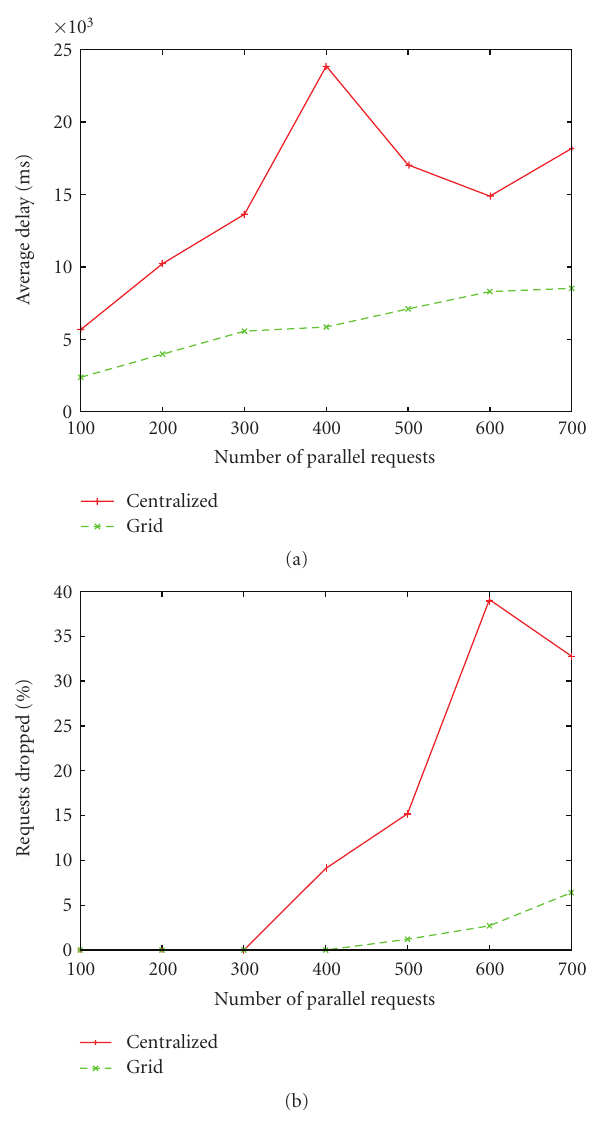
Figure 7: (a) Average delay (ms) versus number of parallel requests for centralized and grid scenarios, (b) requests drop (%) versus number of parallel requests for centralized and grid